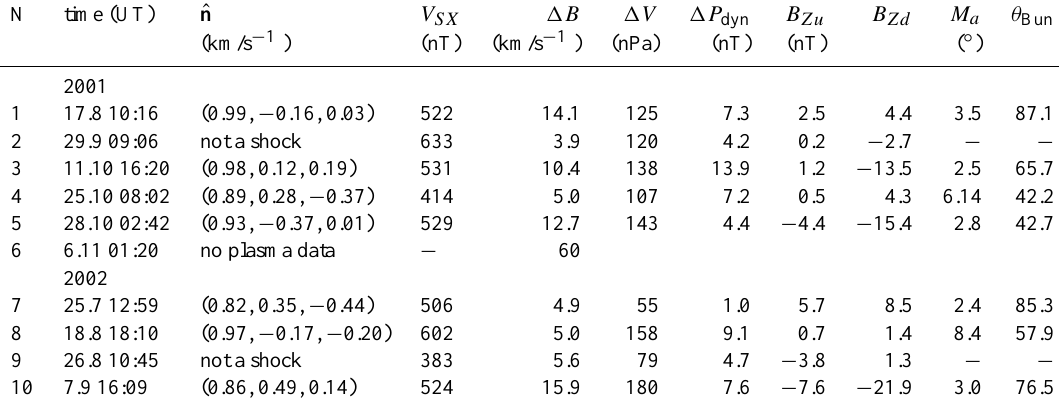
Table 1. Shocks and pressure increases (events 2, 9) associated with the tail lobe SI events. Columns from left to right give the event number (N), time of the shock, shock normal ( n sh ) in GSM, shock speed in the X -direction ( V SX ), changes in the magnetic field magnitude, solar wind speed and dynamic pressure across the shock, and upstream (u) and downstream (d) magnetic field north-south components. The last two columns give the Alfv´enic Mach number ( M a ), and the angle between the upstream magnetic field and the shock normal ( θ Bun ).